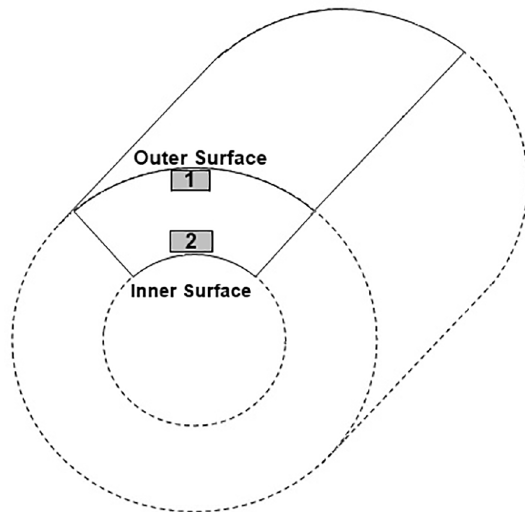
Figure 1. Schematic figure exemplifying the regions of the pipe wall studied in this work.